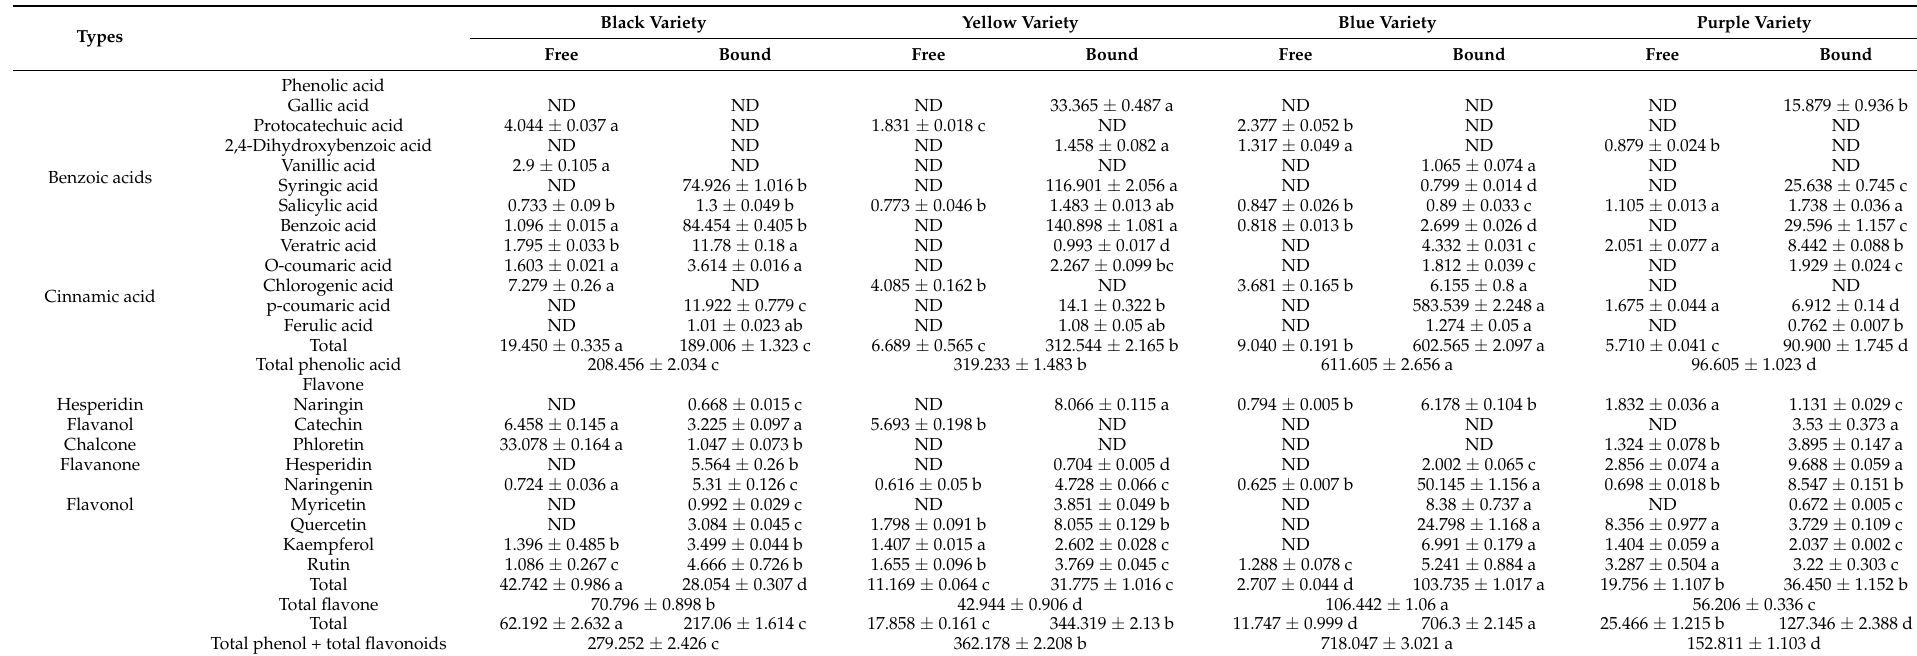
Table 2. Composition and content of phenolic acids and flavonoids in barley of different colors ( µ